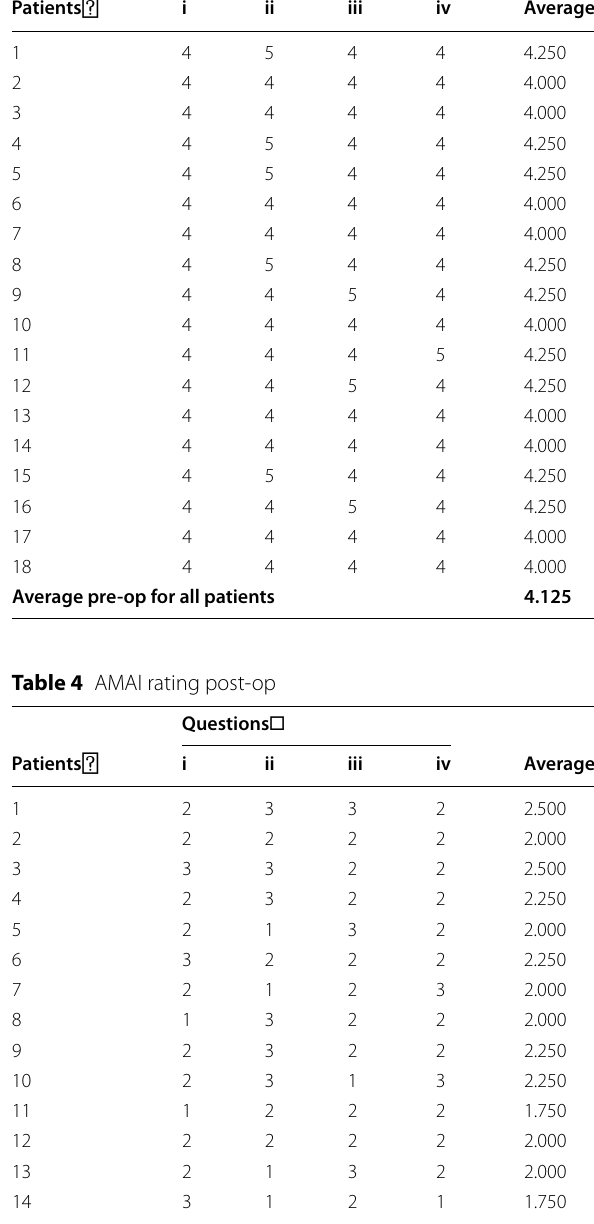
Table 3 AMAI rating pre-op Questions ☐